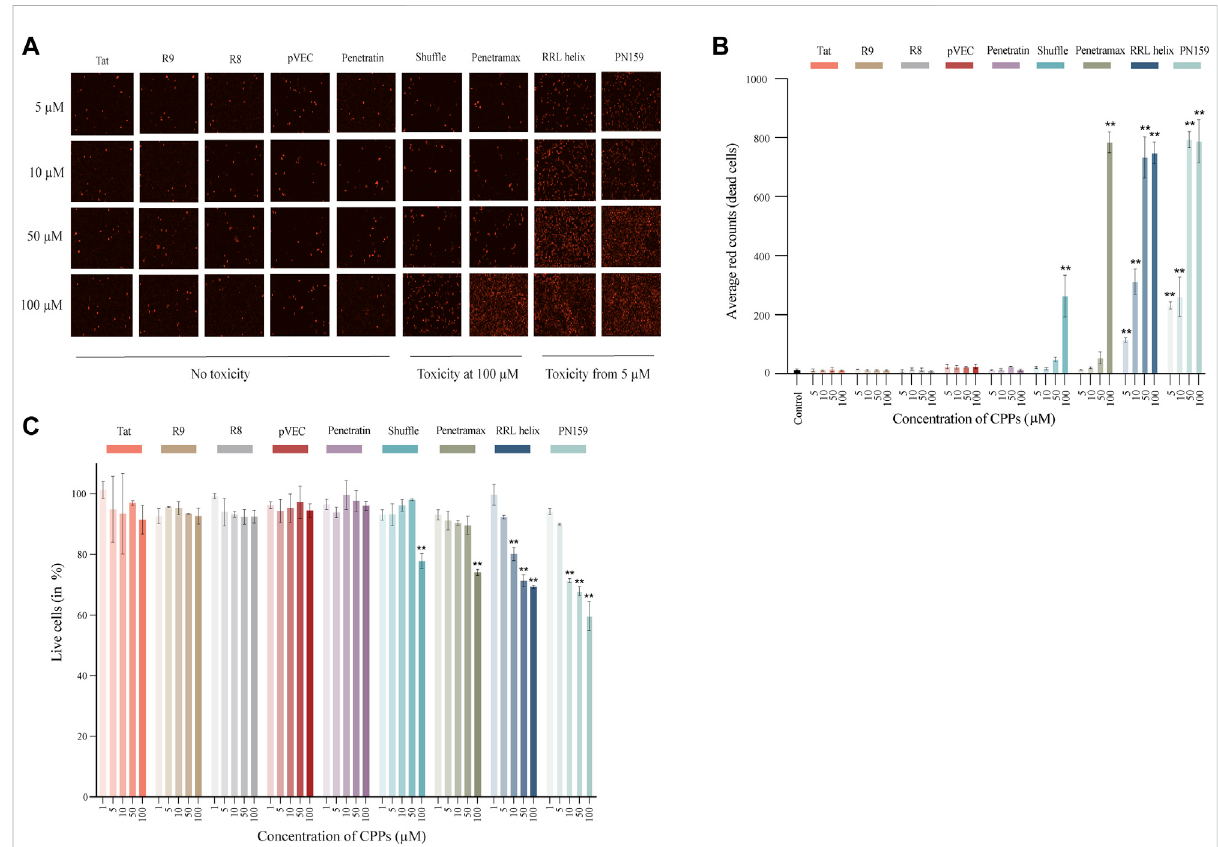
FIGURE 1 CelltoxicityandviabilityofCaco-2cellstreatedwithdifferentCPPs. (A) ImagesofCytotoxReddyestainedCaco-2cellsafter1 htreatmentwith CPPs. (B) Quanti fi cation of average red counts (dead cells) of Cytotox Red dye stained Caco-2 cells using Incucyte standard analysis. (C) AlamarBlue assay after 1 h treatment with different CPPs. The % live cell values given have been normalized to the control wells (considered as 100%